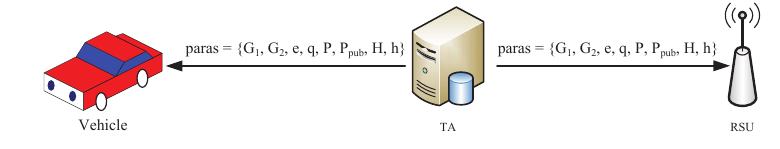
Figure 3. Parameter initialization.